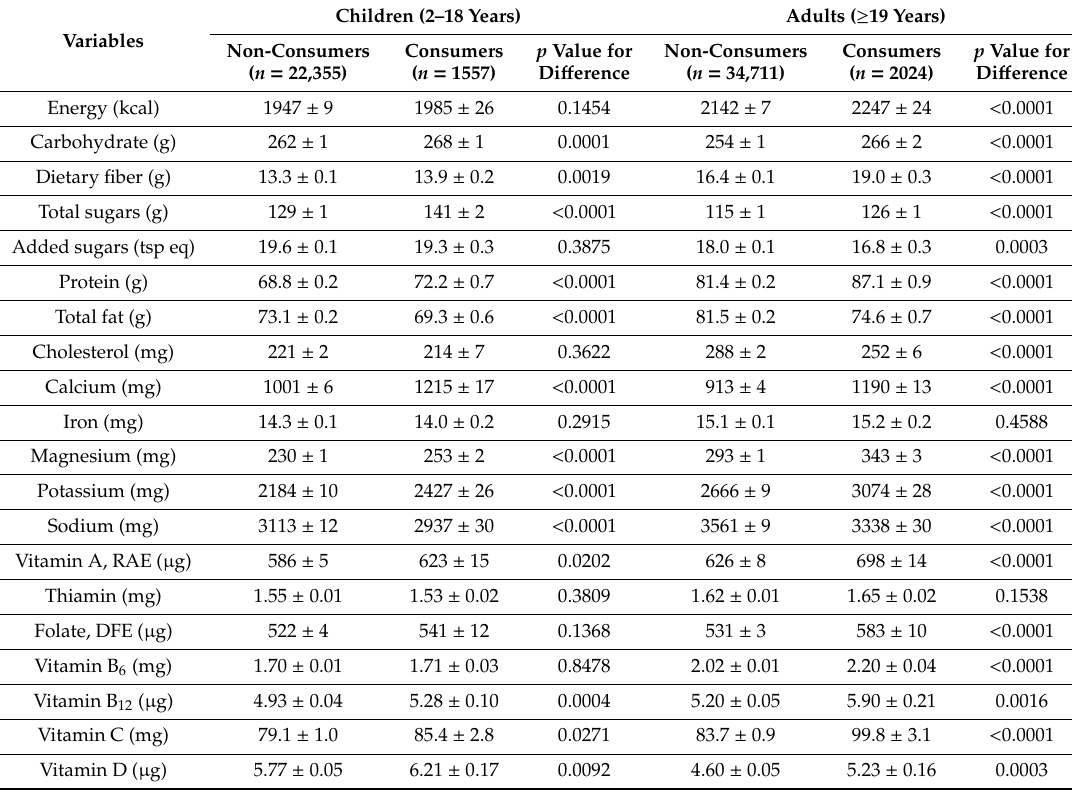
Table 2. Covariate adjusted energy and nutrient intakes in children and adult yogurt consumers and non-consumers (NHANES 2001–2016, gender combined